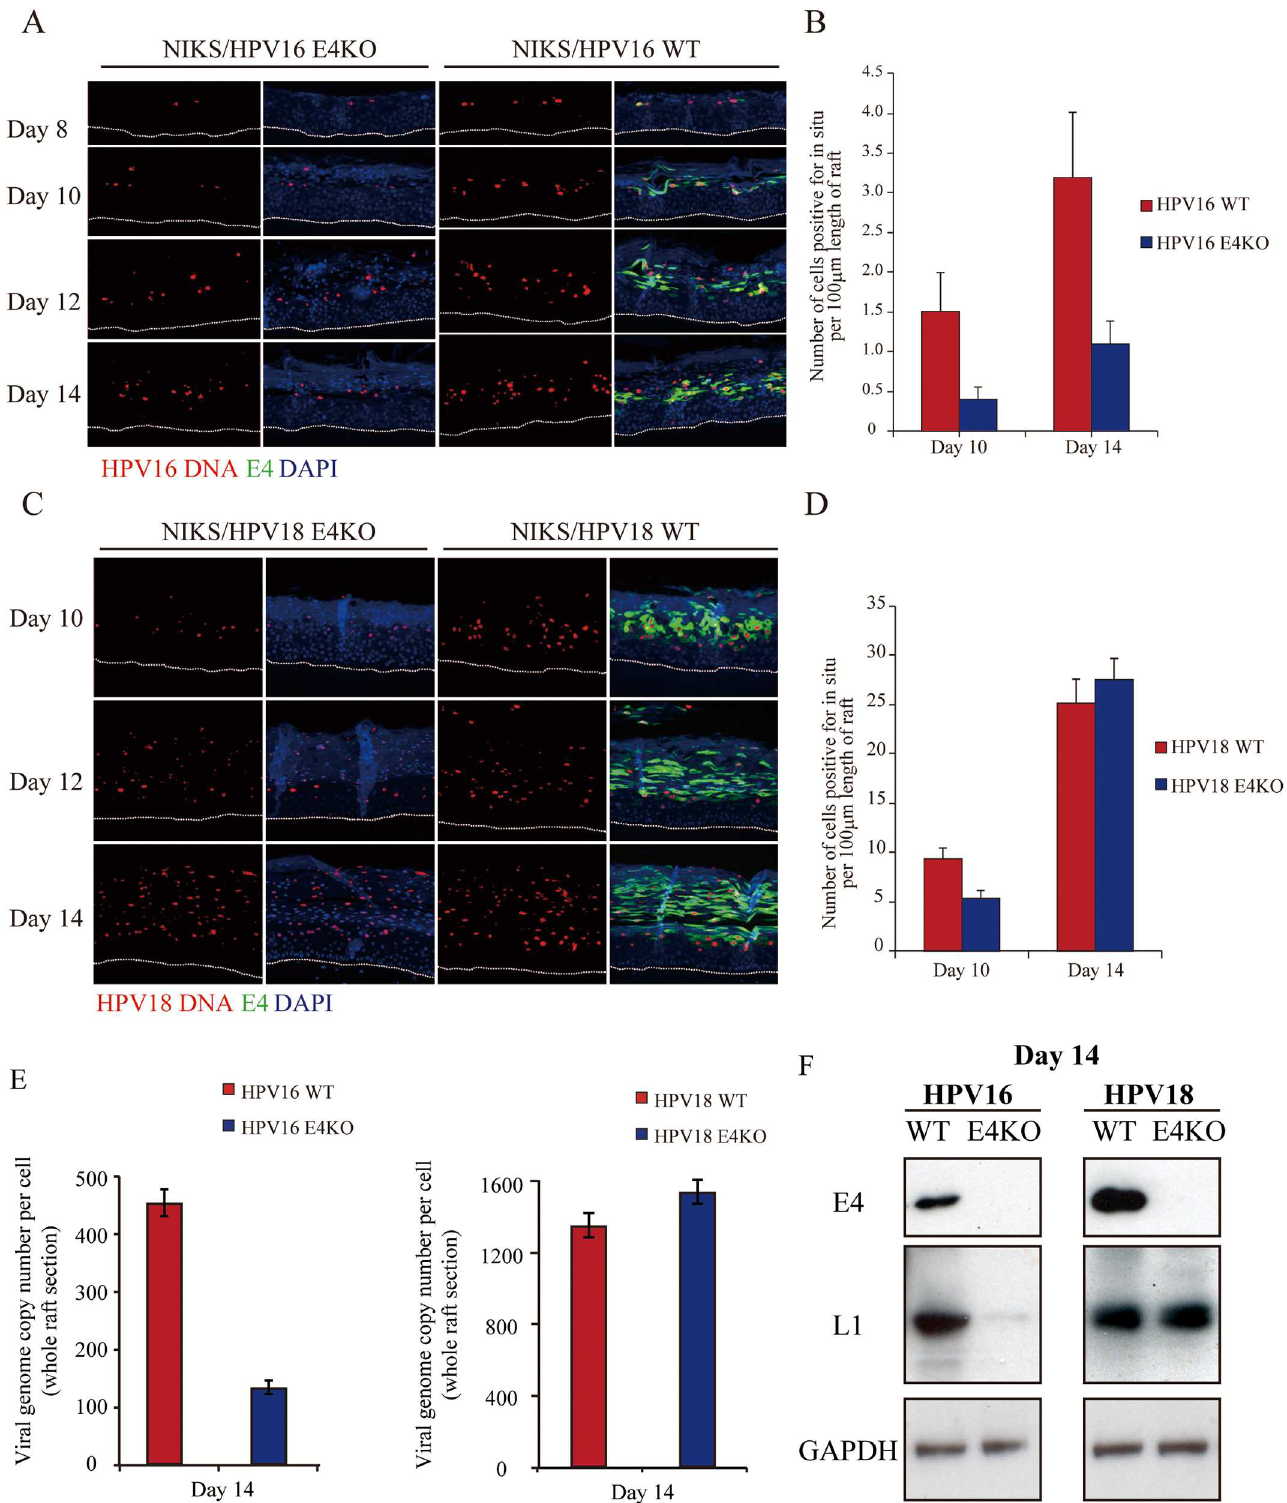
Fig 2. Differentiation dependent HPV genome amplification is delayed rather than abolished in the absence of E1^E4. (A) Viral genome amplification after differentiationwas detected by in situ hybridization (red) in raft tissues generatedfrom NIKS cells harboringHPV16 WT or E4KO genomes.Time post-differentiation is indicatedin days on the left. Stainingfor E1^E4 and DNA (DAPI) are shown as green and blue. The dotted line